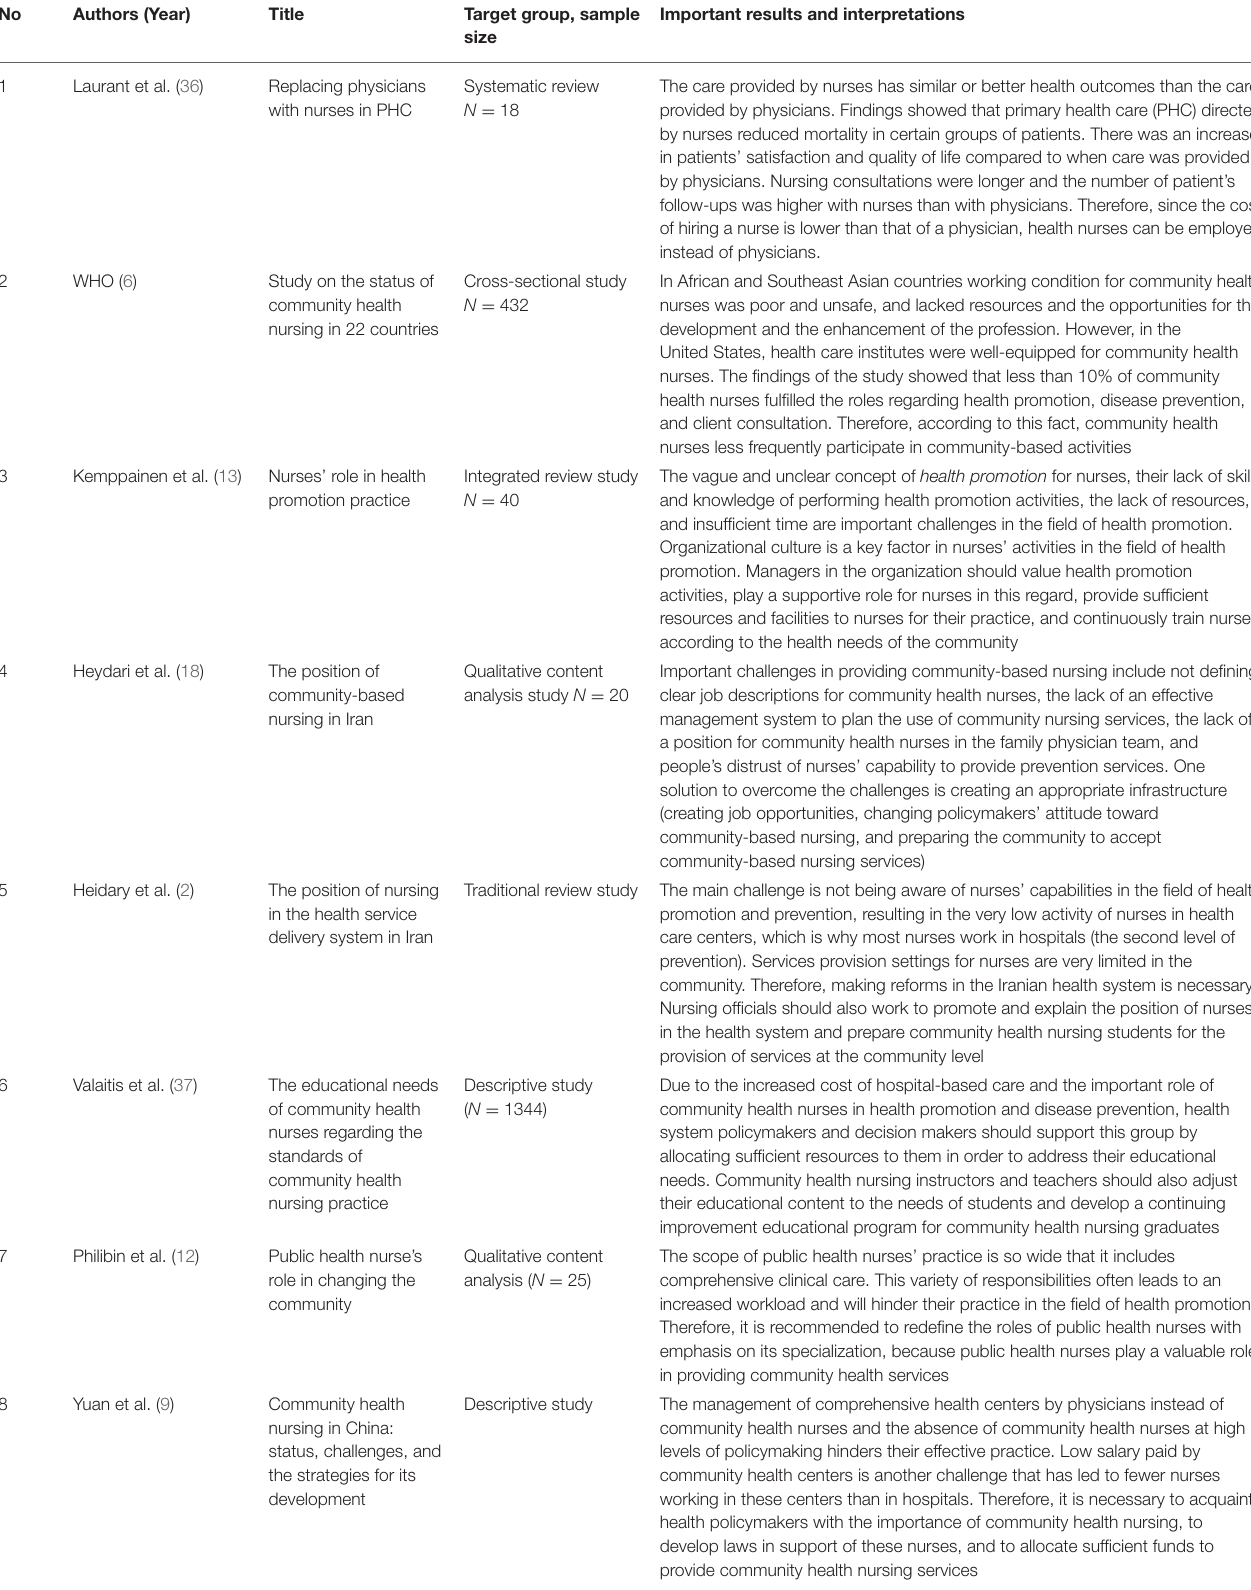
TABLE 2 | A summary of the critical review of previous Iranian and foreign